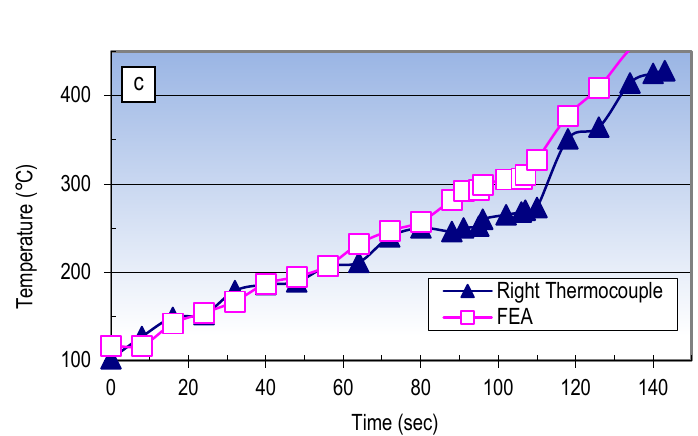
Figure 4: Temperature profiles at three thermocouple locations during preheating at (a) left, (b) center, and (c) right positions. GTAW preheating at 90A, 14.5V. Surface heating above the left thermocouple (0-95 sec), switching to right location (95-110 sec), and then surface heating above the right thermocouple (110-145 sec).